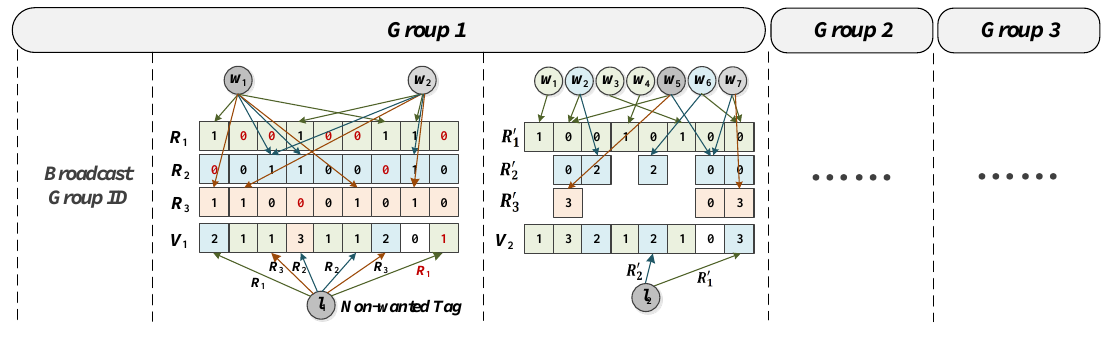
Figure 2. Illustration of the B-Search tag searching